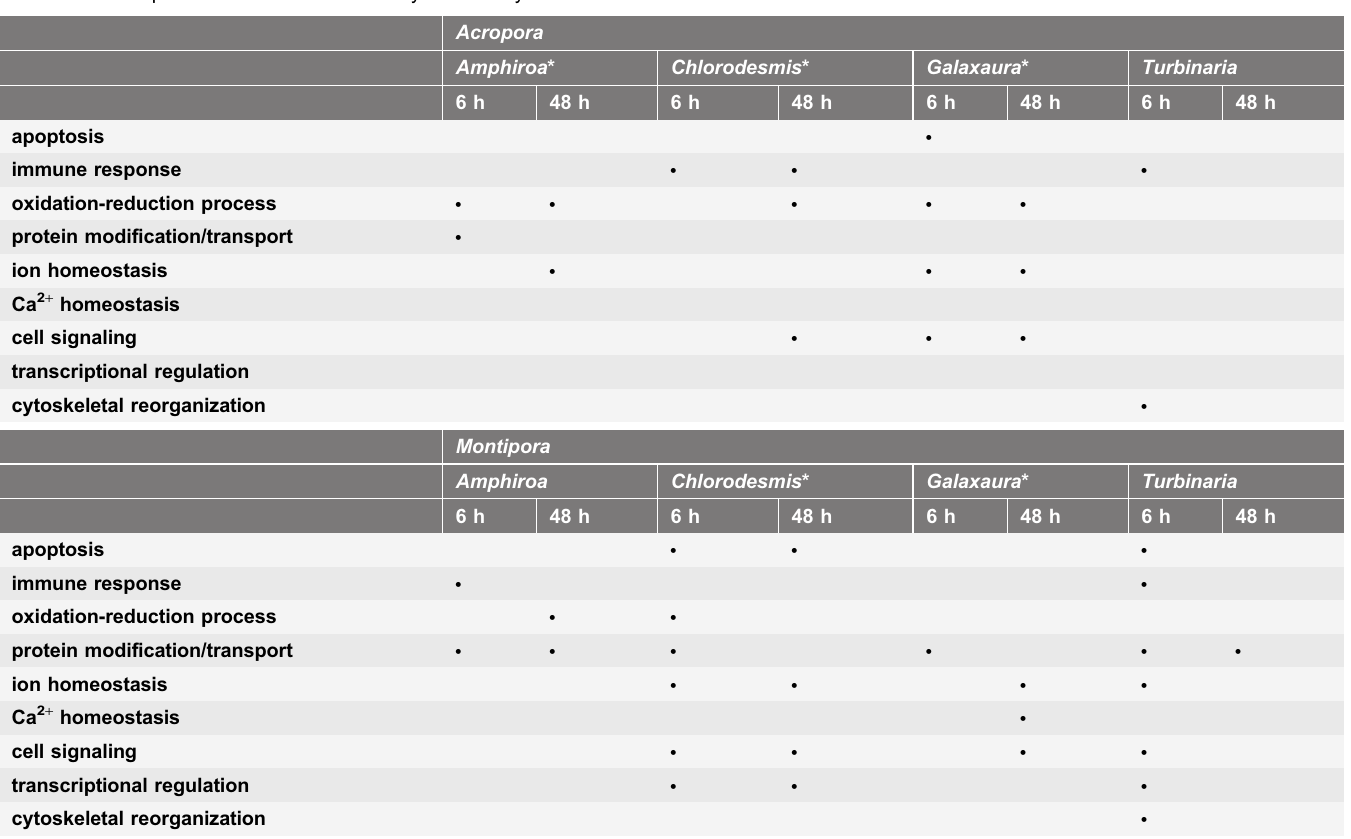
Table 2. Cellular processes of corals commonly affected by external stressors.